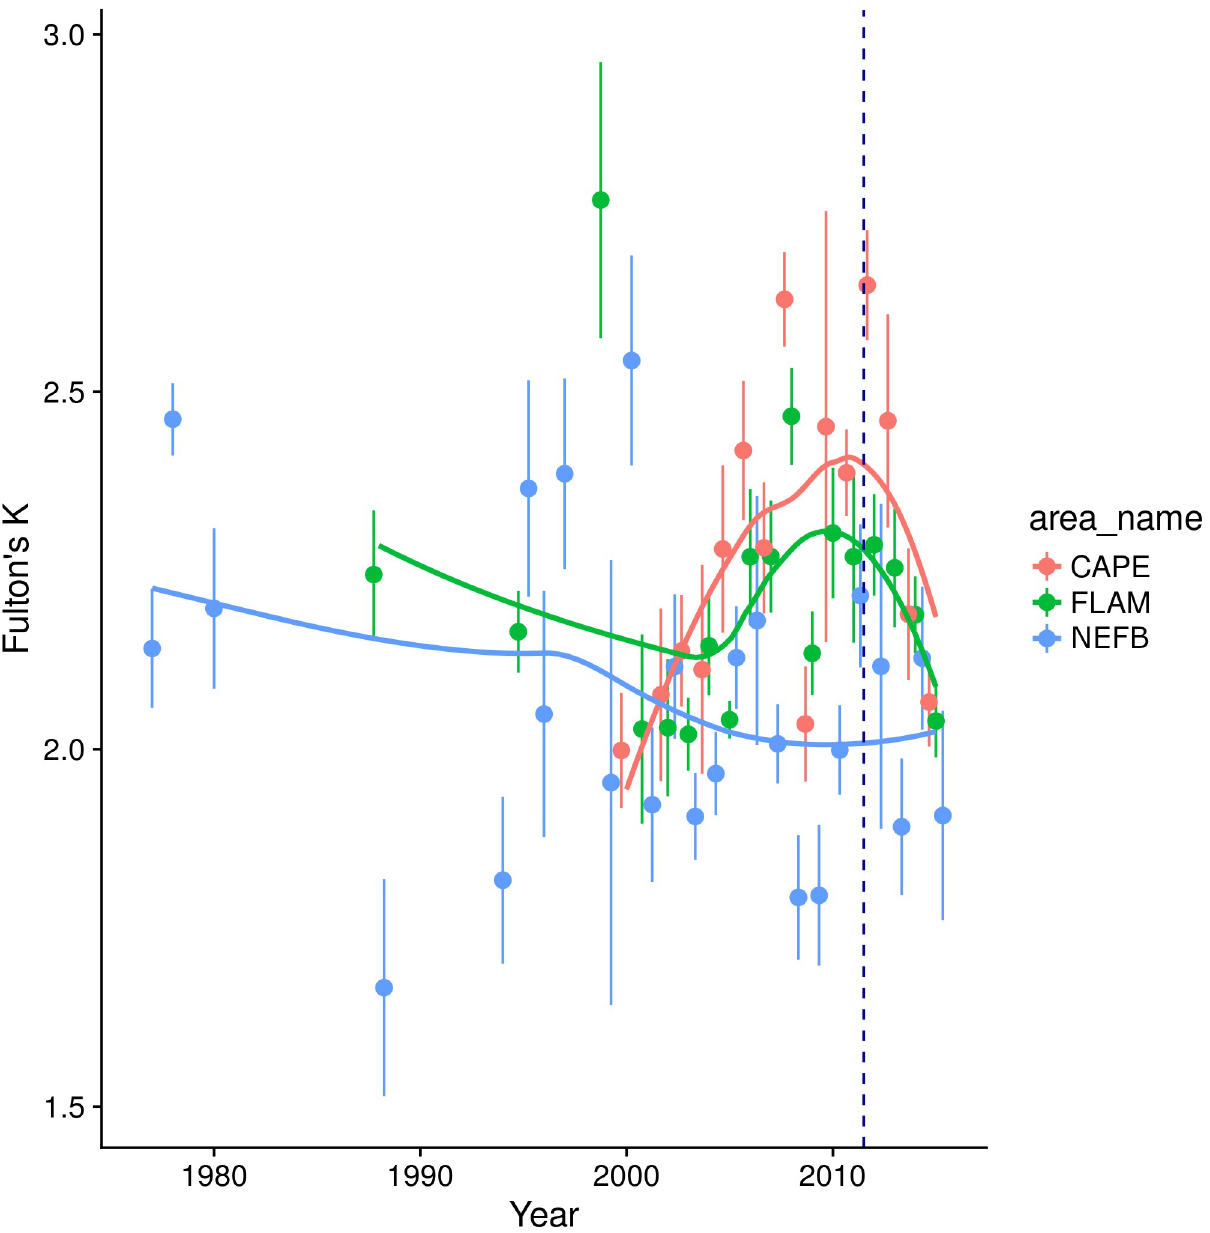
Fig 6. Fulton’s K body condition factor of American crocodiles ( Crocodylus acutus ) captured in South Florida between 1978 and 2015. Areas included within Everglades National Park (CAPE = Cape Sable, FLAM = Flamingo area, NEFB = NE Florida Bay). Filled circles represent mean values and error bars extend to ± 1SE, dashed line at 2012 indicates start of C-111 Spreader Canal Restoration